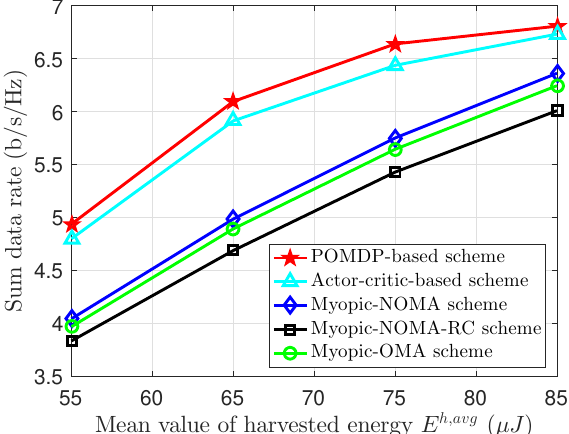
Figure 7. The sum data rate according to the mean value of harvested energy.